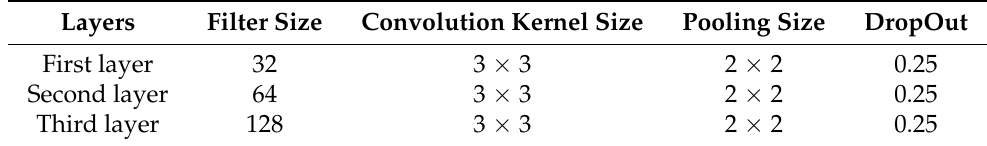
Table 10. Details of the parameters used in